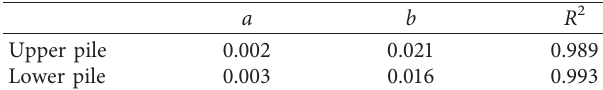
Figure 10: Linear fitting curve of upper and lower piles. (a) Curve fitting of upper pile. (b) Curve fitting of lower pile. Table 2: The load transfer parameters a and b and the determinable coefficient R 2